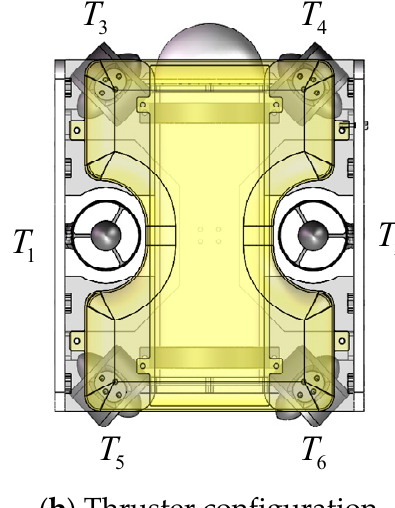
Figure 8. Path tracking results for the straight line.